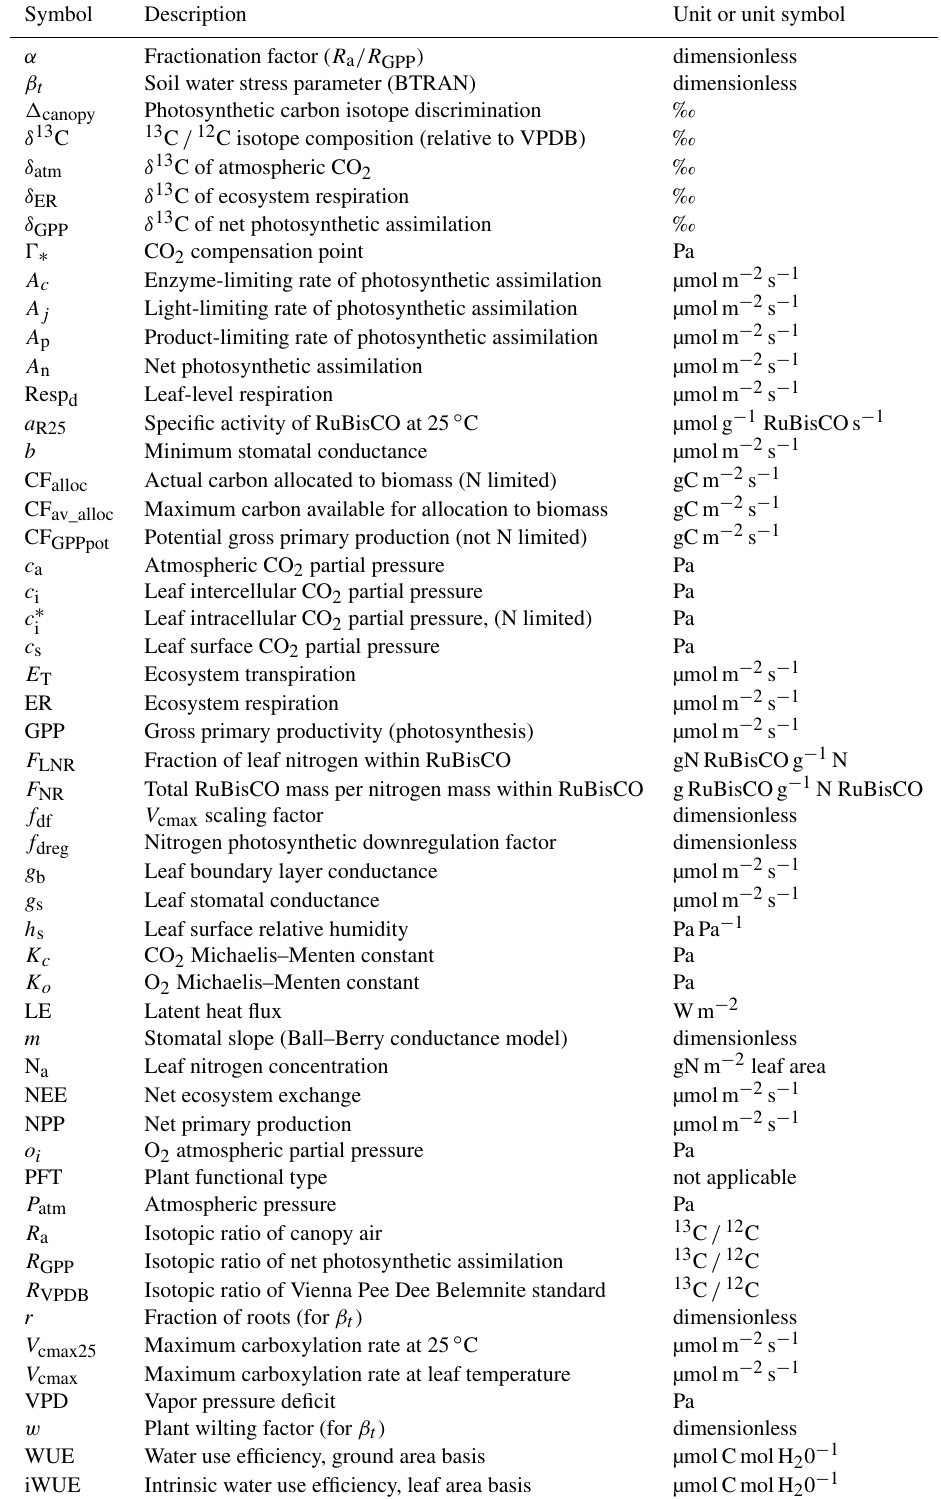
Table 1. List of symbols